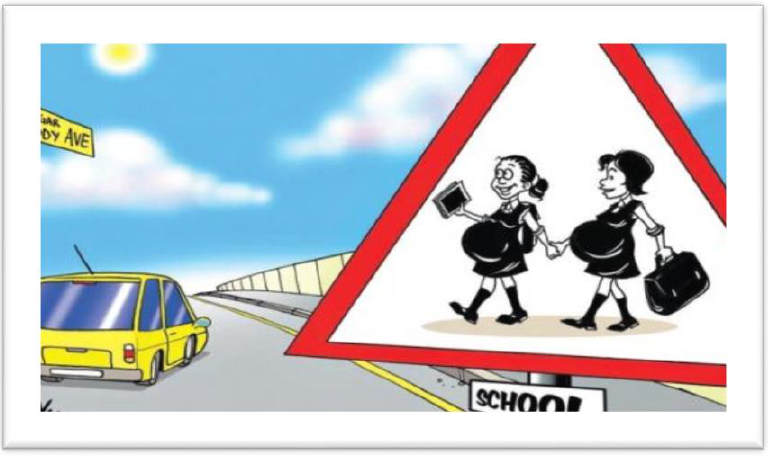
Figure 4. Cartoon D: School pregnancies (Yalo Feb 22, 2011